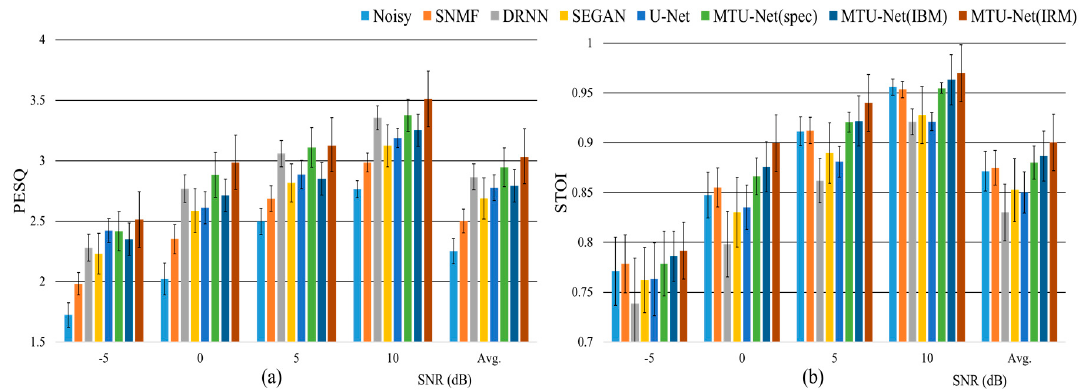
Figure 5. Comparison of the objective quality measures for seven different speech enhancement methods applied to the matched evaluation dataset: ( a ) perceptual evaluation of speech quality (PESQ) and ( b ) short-time objective intelligibility (STOI).